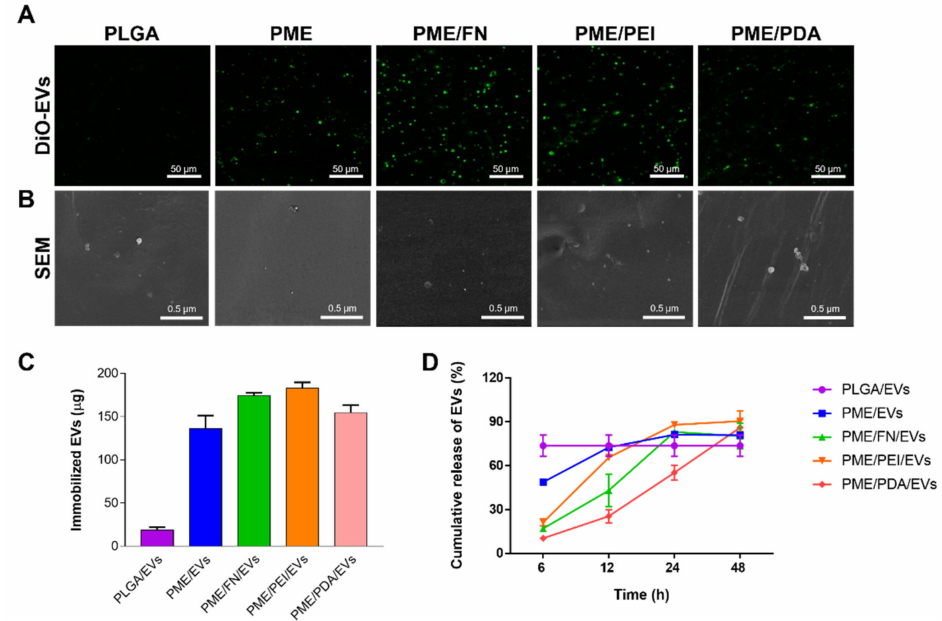
Figure 3. Immobilization of EVs onto the composite. ( A ) Representative confocal images showing the distribution of DiO-labeled EVs on the surface of composite films. Scale bars = 50 µ m. ( B ) Repre- sentative SEM images of EV-grafted films. Scale bars = 0.5 µ m. ( C ) Quantification of immobilized EVs on the composite films. ( D ) EVs release